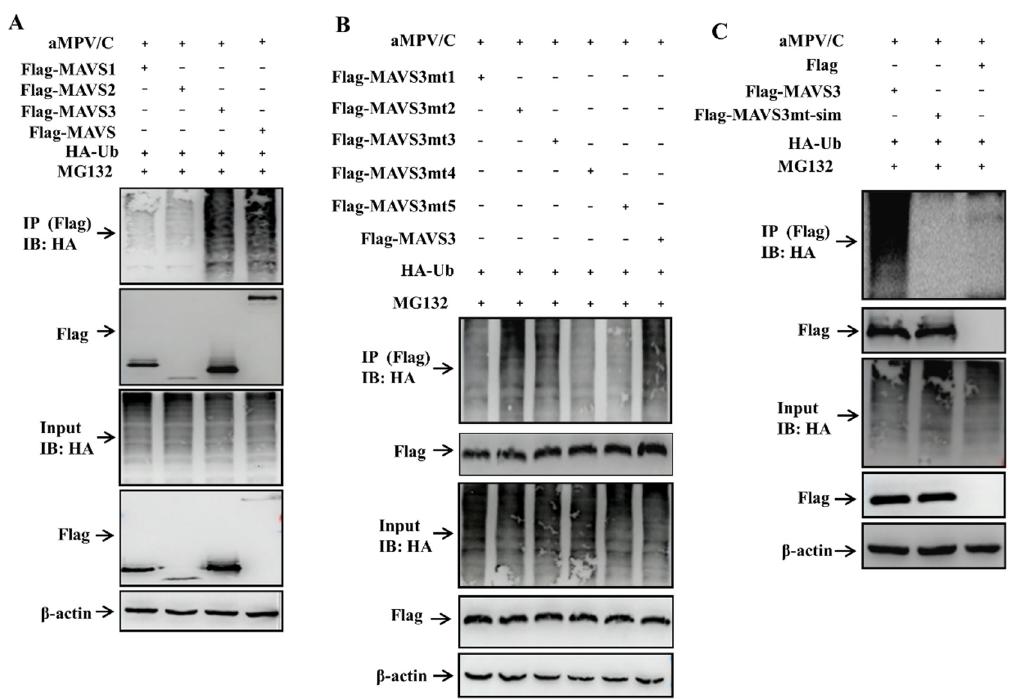
Figure 5. The critical sites for MAVS polyubiquitination are identified. ( A ) Vero cells were co-transfected with Flag-MAVS1, Flag-MAVS2, Flag-MAVS3, or Flag-MAVS and HA-Ub. After 6 h transfection, the cells were infected with aMPV/C (MOI = 0.5) for 48 h in the presence of MG132, and analyzed by IP with anti-Flag antibody or Western blot with anti-HA antibody. In addition, Flag, HA and β -actin in aMPV/C-infected cells detected by immunoblotting were used as an input control and an internal loading control, respectively. aMPV/C infection was verified with antiviral N antibody. ( B ) Vero cells were co-transfected with Flag-MAVS3mt1, Flag-MAVS3mt2, Flag-MAVS3mt3, Flag-MAVS3mt4, Flag-MAVS3mt5 or Flag-MAVS3 and HA-Ub. The cells were infected with aMPV/C and analyzed as described in ( A ). ( C ) Vero cells were co-transfected with Flag, Flag-MAVS3 or Flag-MAVS3mt-sim and HA-Ub. The cells were infected with aMPV/C and analyzed as described in A.